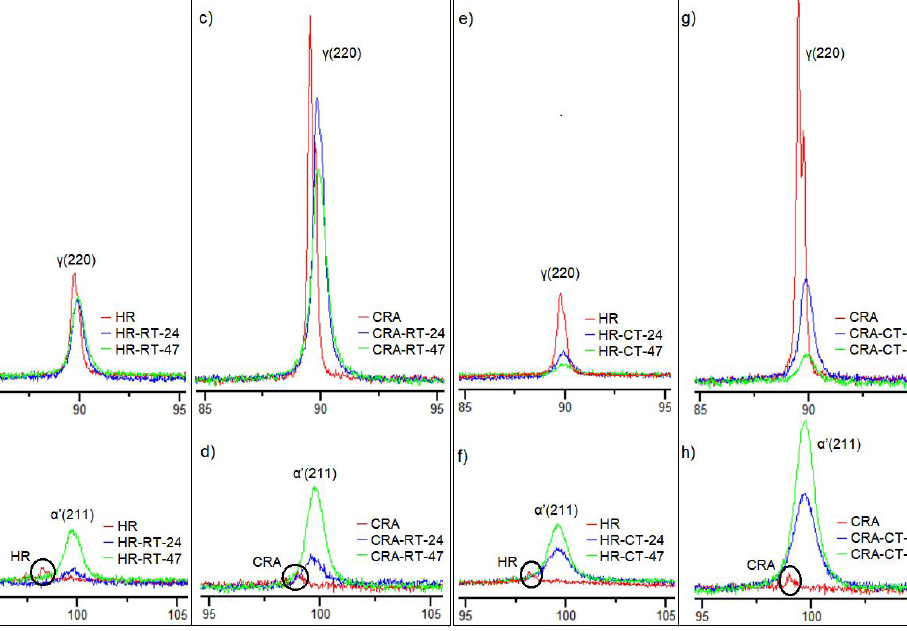
Figure 9. Displacement and/or widening peaks (γ and α’) after martensitic transformation at 298 K (a-d) and 155 K (e-h) by tensile